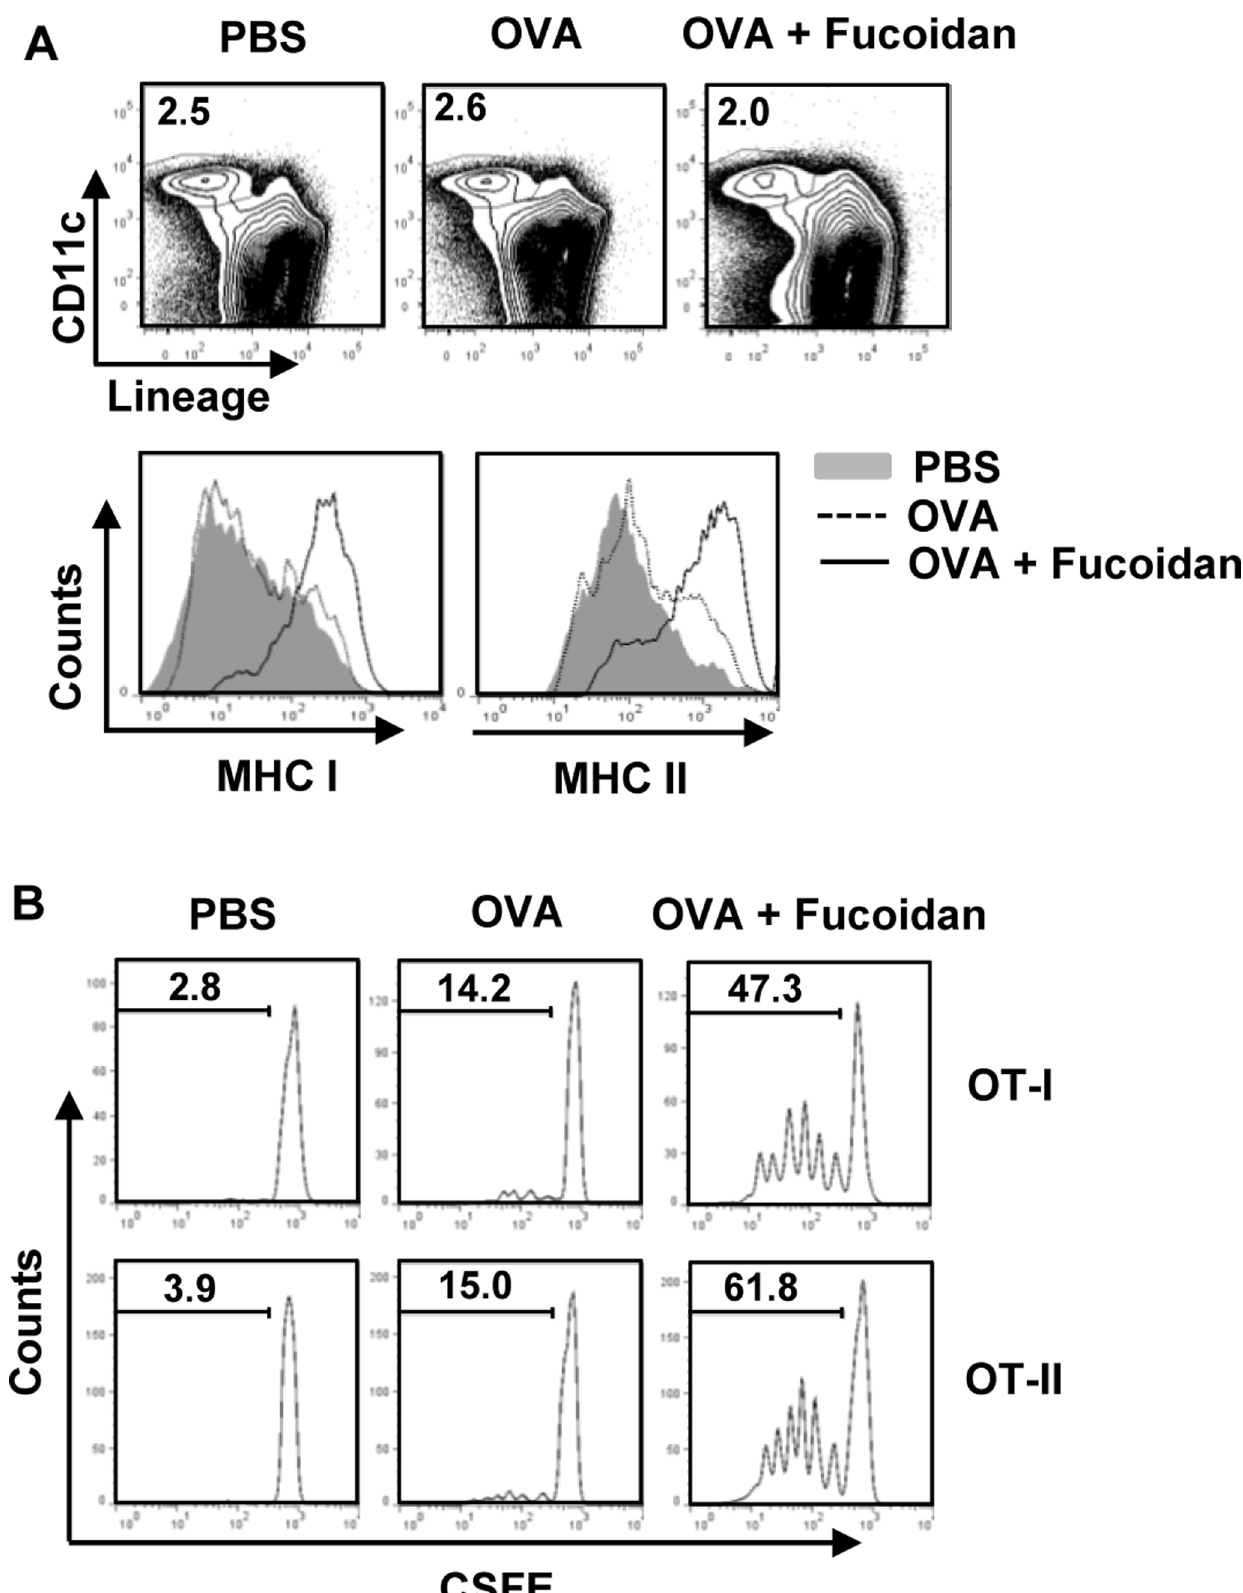
Figure 5. Fucoidan promotes antigen presentation and antigen-specific T cell proliferation invivo . (A) C57BL/6 mice were injected with PBS, OVA or OVA + fucoidan for 24 hrs, and the expression levels of MHC class I and II on the gated Lineage 2 CD11c + cDCs in splenocytes from these